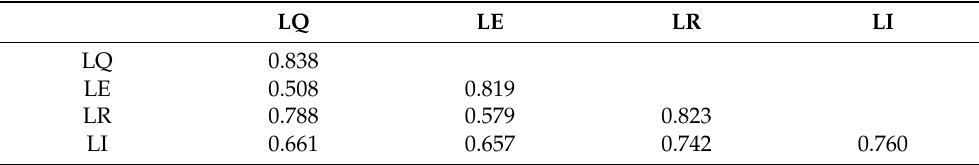
Table 4. Assessment of discriminant validity in the case of the analyzed